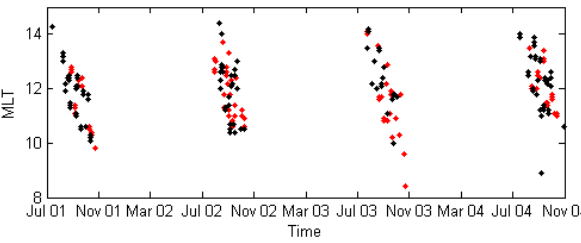
Fig. 2. Magnetic local time (MLT) of each cusp crossing versus time. Crossings occurring in the Northern and Southern Hemi- spheres are shown in black and red, respectively.